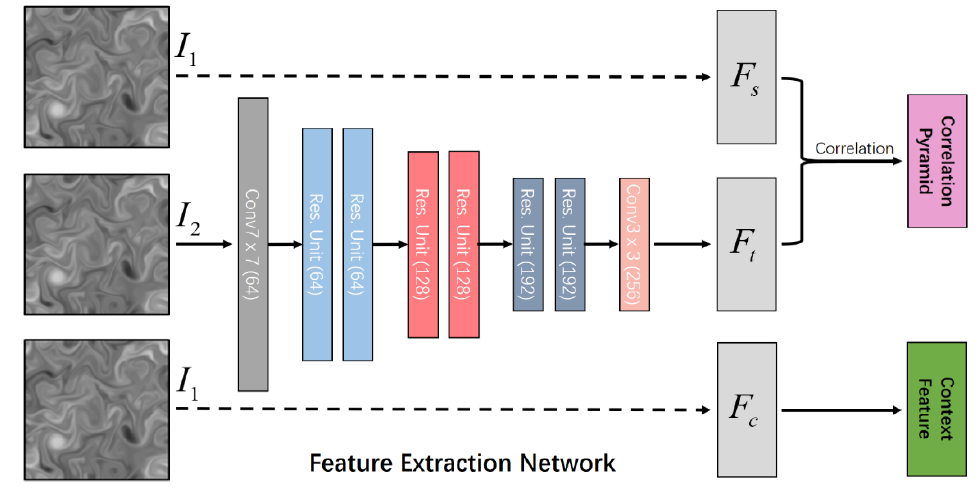
Figure 1. The structure of the feature extraction network.